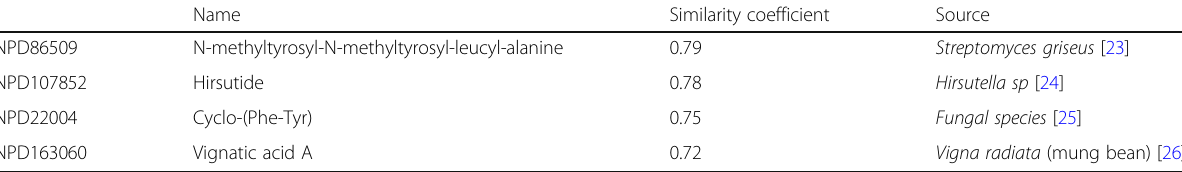
Table 1 Result of similarity indexing in comparison with an inhibitor against UNPD natural compound database with their